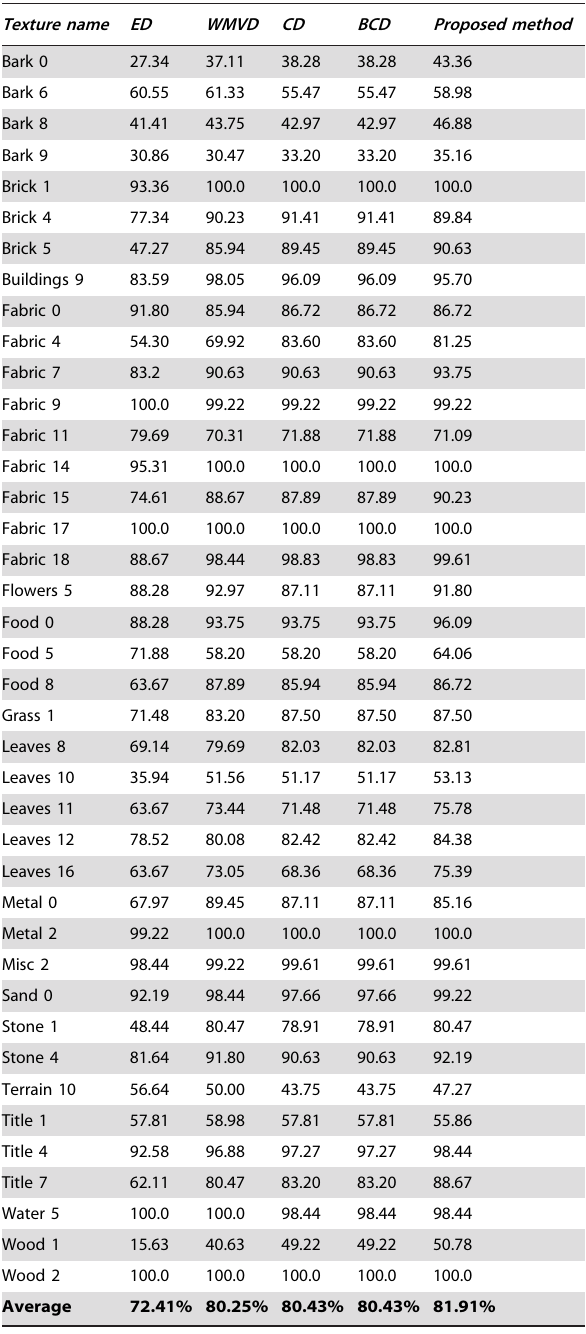
Table 2. Comparison of retrieval performance of different types of metrics for texture image retrieval using DT-CWT on the MIT image database (640 images of 40 different